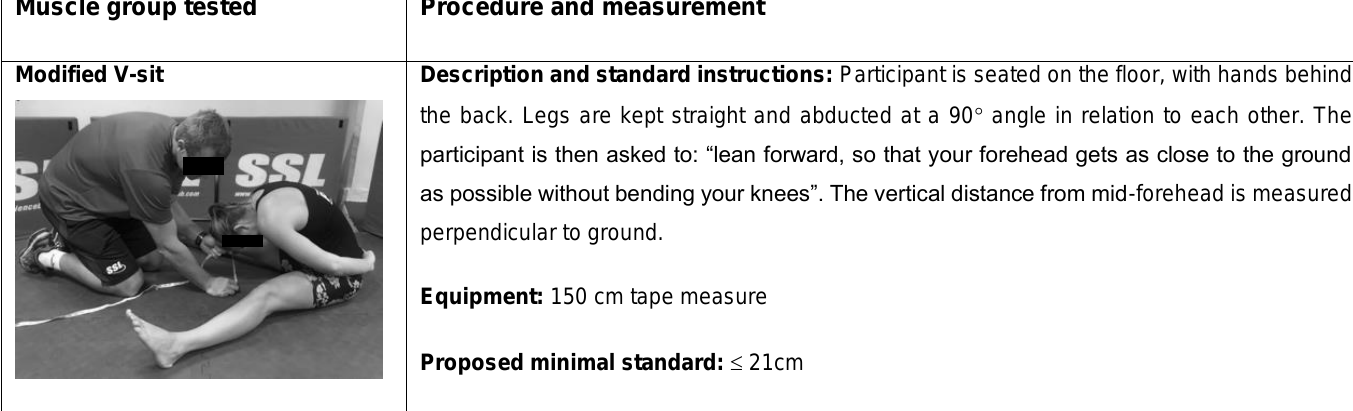
TABLE 1-A1: Sport Science Lab ® Screening Test Protocol. Muscle group